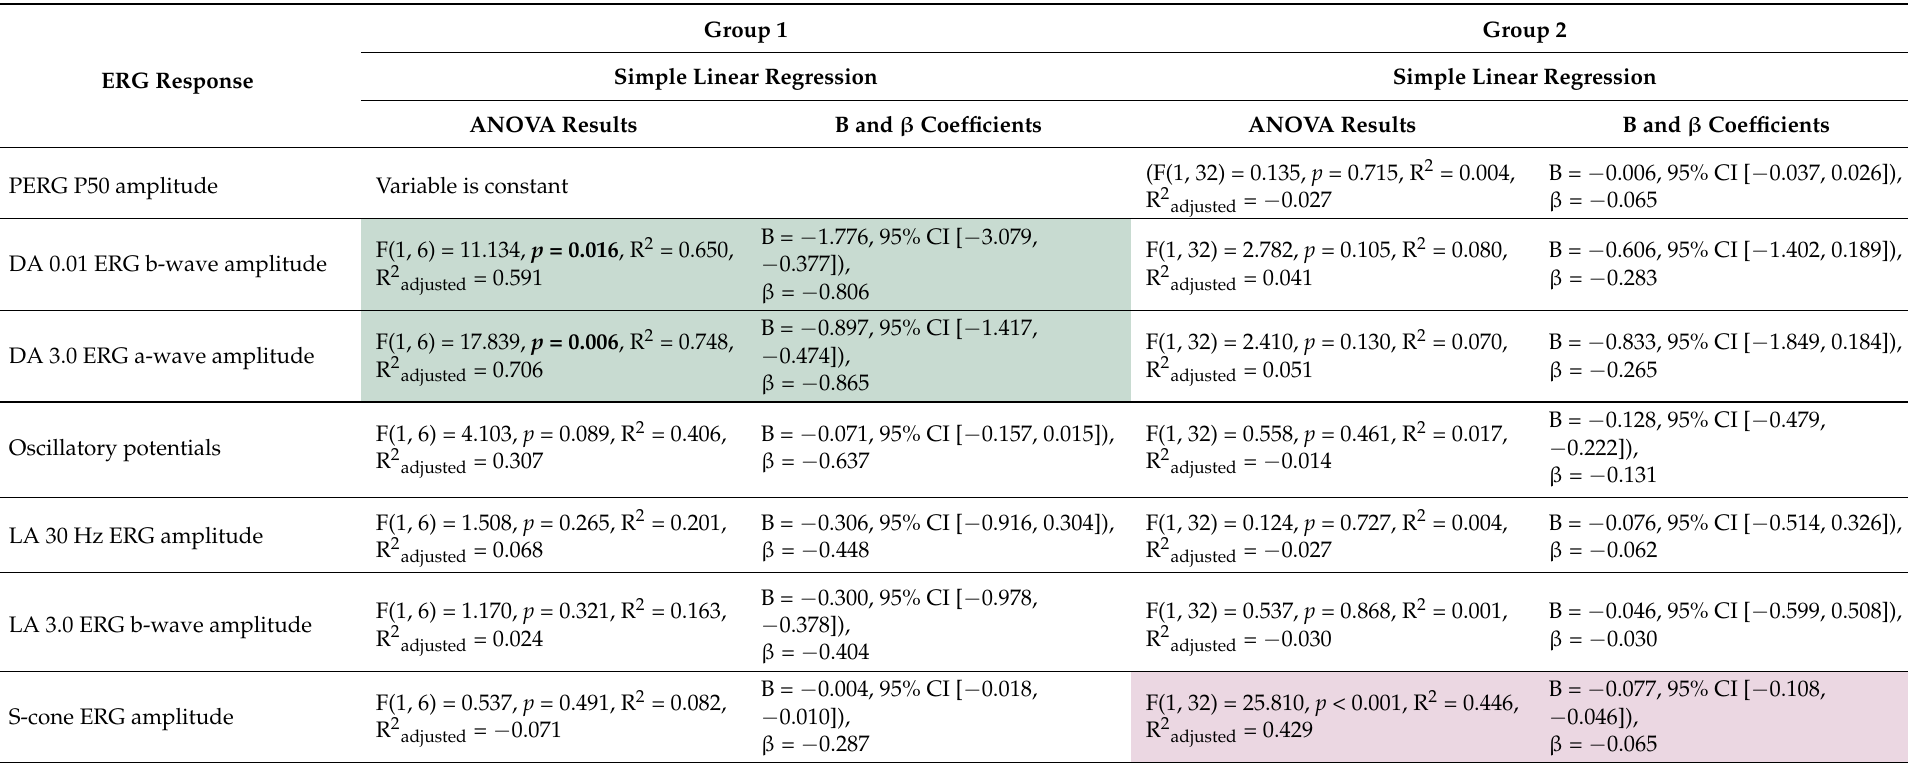
Table 3. Results of statistical analysis (simple linear regression) investigating the correlations between age and different ERG parameters within the two patient